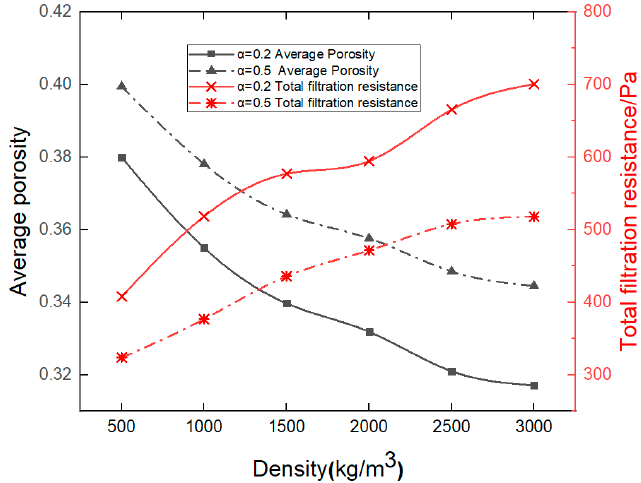
Figure 4. Effect of density on the average porosity and the total filtration resistance of the filter cake.